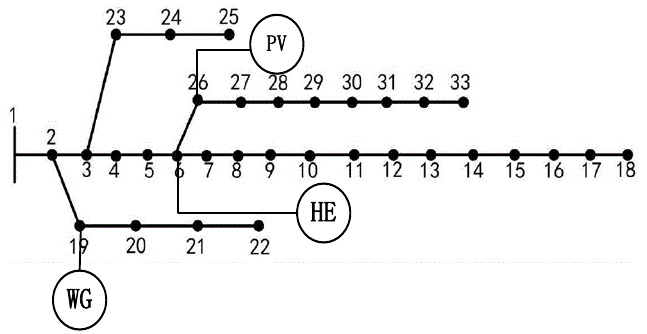
Figure 5. Example system of PV, WG, and HESS access in ADN.